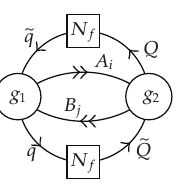
Figure 8: Quiver diagram of the KS theory with chiral